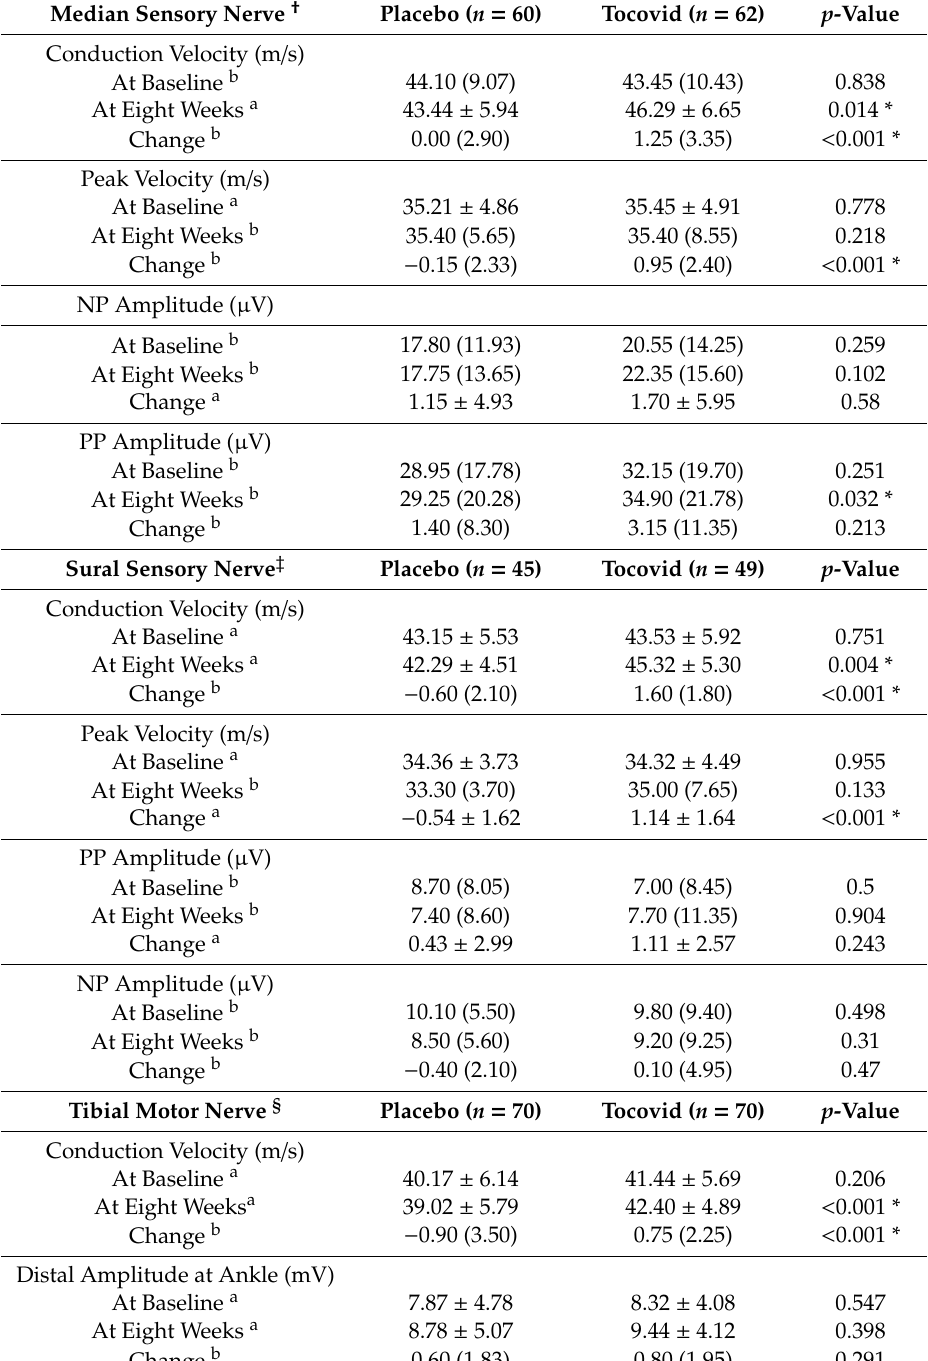
Table 3. Comparison of nerve conduction parameters between the Tocovid and placebo